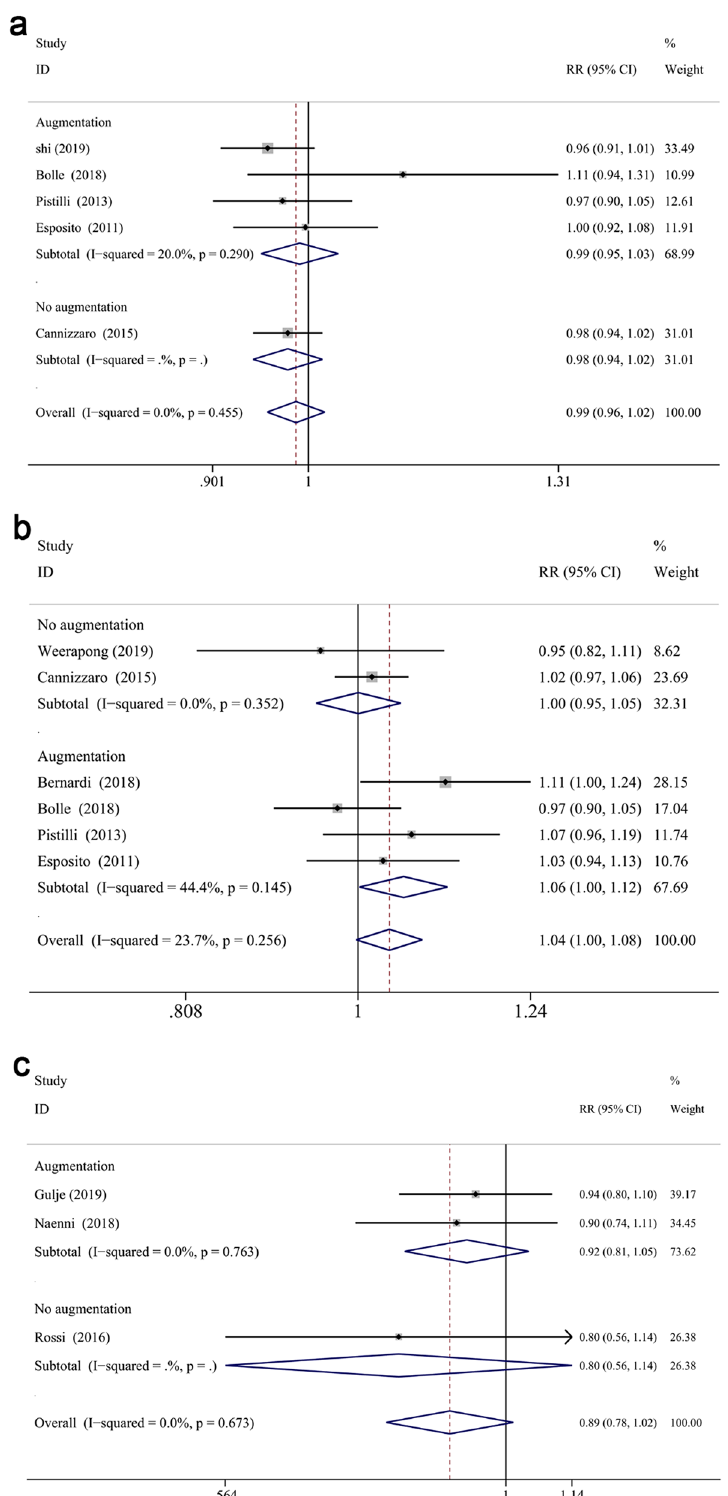
Figure 5. Subgroup analyses for the effects of augmentation on survival rate in the maxilla ( a ) and mandible ( b ) after 1-year measurement, maxilla ( c ) after 5-year measurement. Mantel–Haenszel (MH)-weighted RR < 1 indicated a lower survival rate of extra- short implants than the longer